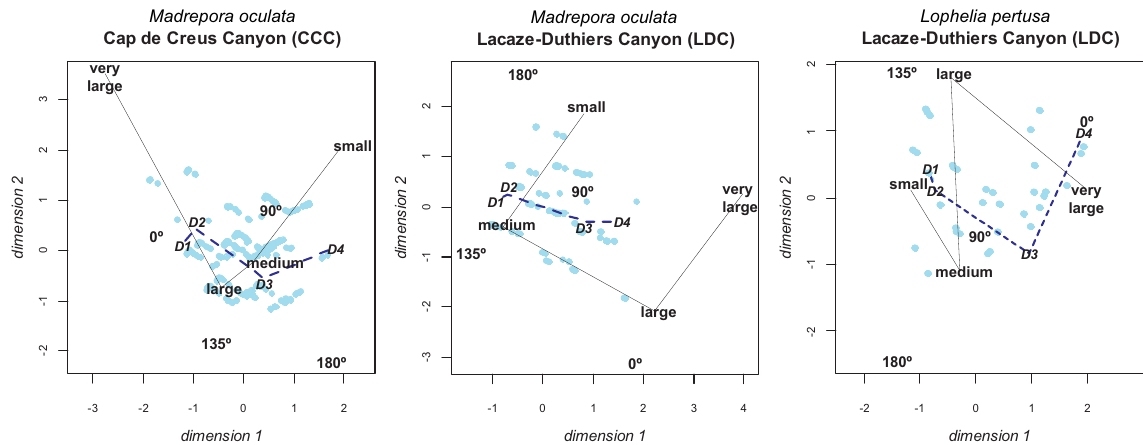
Fig. 7. Correspondence analysis showing the relationship between Madrepora oculata and Lophelia pertusa colony size, colony orientation and depth in the Cap de Creus Canyon (CCC) and the Lacaze-Duthiers Canyon (LDC). Samples are shown by dots; the ordinal categories of size and depth (increasing from D1 to D4) are connected by solid and dashed lines,